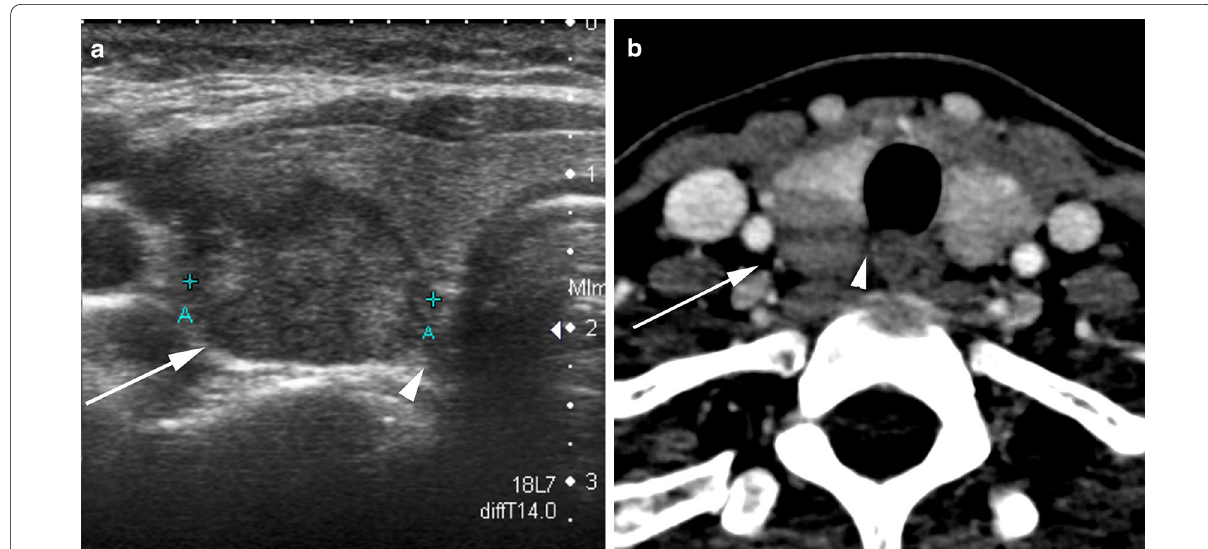
Fig. 12 40-Year-old female with PTC in the posterior aspect of right lobe of thyroid gland. Transverse ultrasound image ( a ) shows a 13 mm PTC with loss of intervening normal thyroid parenchyma between the PTC and anatomic course of recurrent laryngeal nerve (RLN) (arrowhead). Corresponding axial contrast enhanced CT scan at the level of the PTC ( b ) again confirms the absence of intervening normal thyroid parenchyma between the PTC and the expected course of RLN (arrowhead) with protrusion of the nodule posteriorly beyond the margin of the gland. The patient was therefore not offered AS in our study